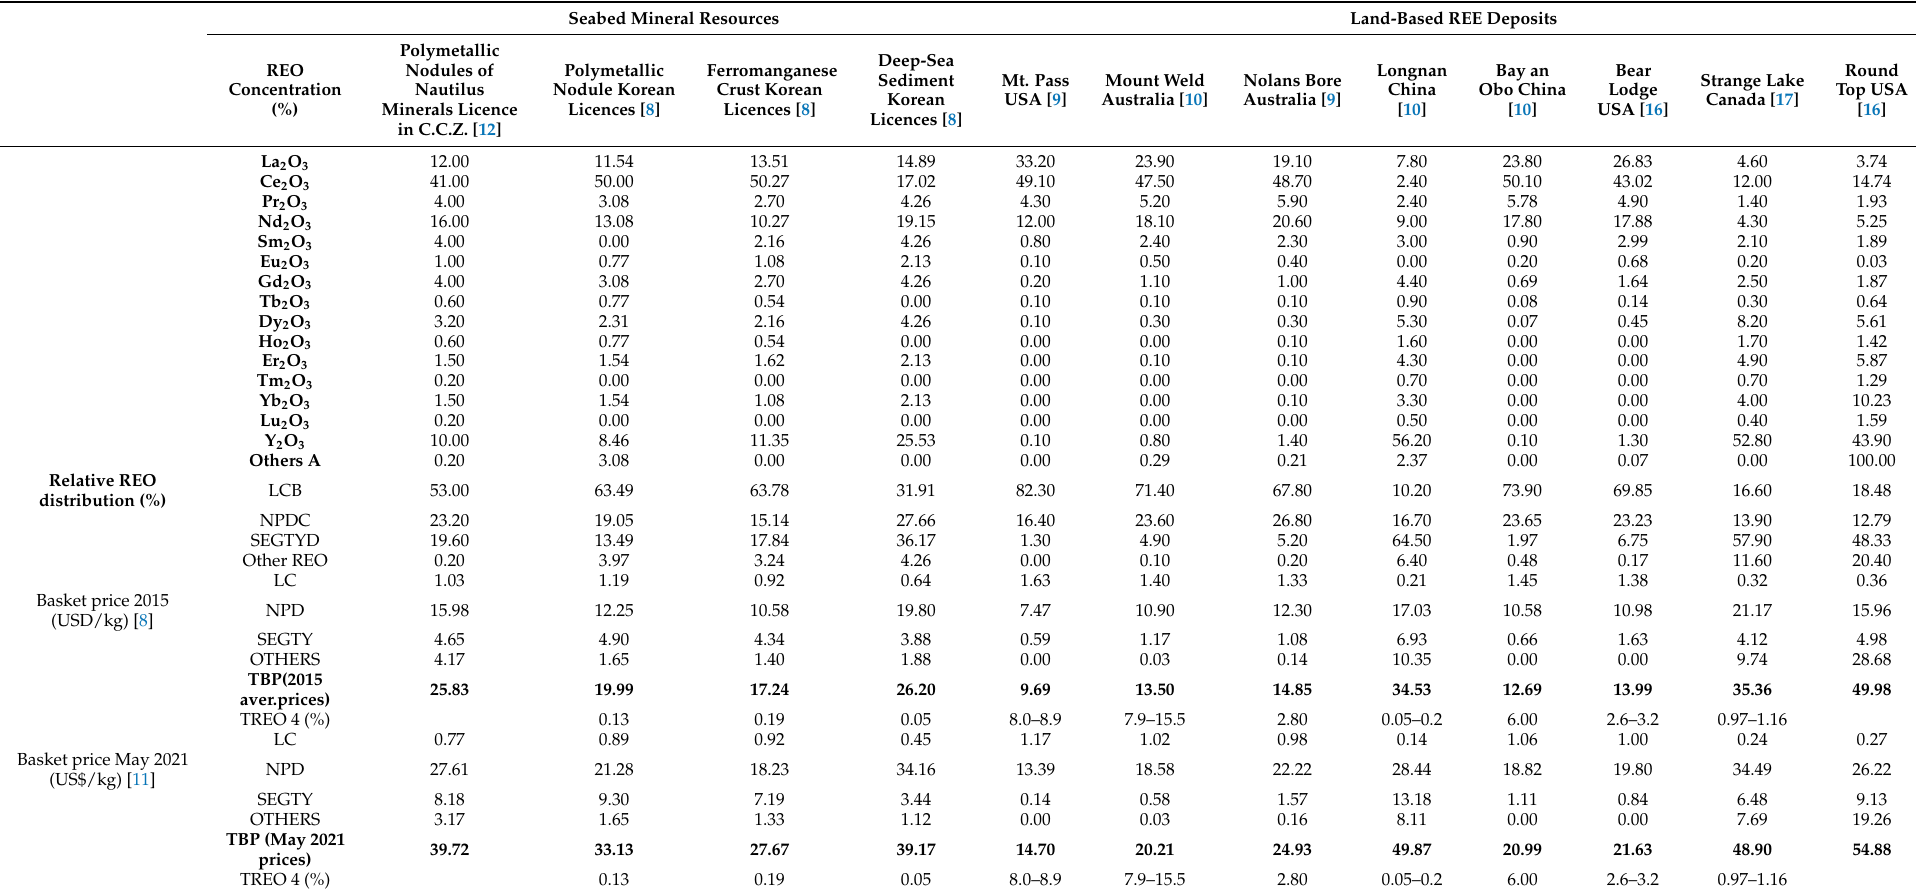
Table 6. Mean REO concentrations, REO relative split and calculated total basket prices (contained value) of the studied deep-sea deposits compared with the selected well-known REE land-based